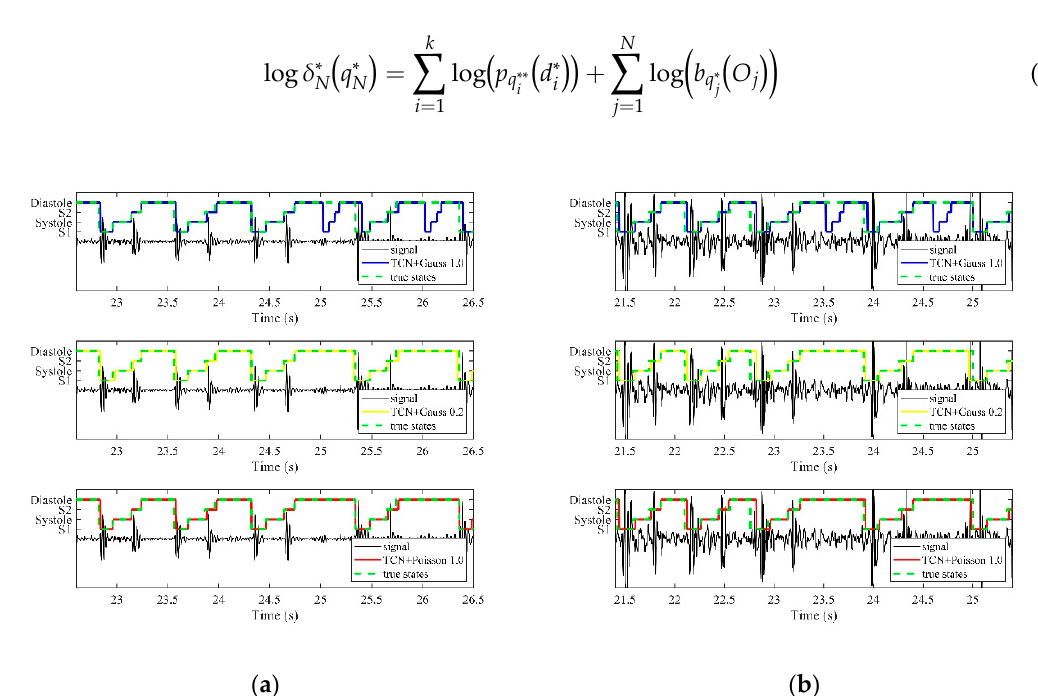
Figure 10. Comparison of different state annotation algorithms with arrhythmia heart sounds. ( a ) LH-training No. 555. ( b ) PN-training-a No. 7. TCN + gauss 1.0 used the previous Viterbi algorithm. TCN + Gauss 0.2 used the Viterbi algorithm changed the weights of the state duration probabilities. TCN + Poisson 1.0 used the Viterbi algorithm changed the diastolic distribution for Poisson distribution.